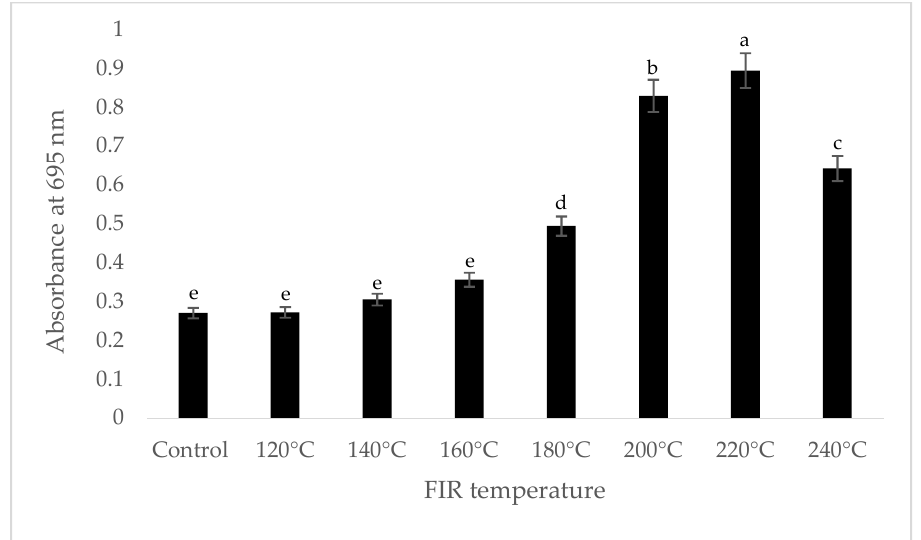
Figure 4. Total antioxidant capacity of A. gigas Nakai treated by FIR irradiation (PPMD assay). Values are the mean ±SD ( n = 3). Different lowercase letters within the row indicate significant differences ( p <0.05) according to ANOVA. FIR: far infrared irradiation.